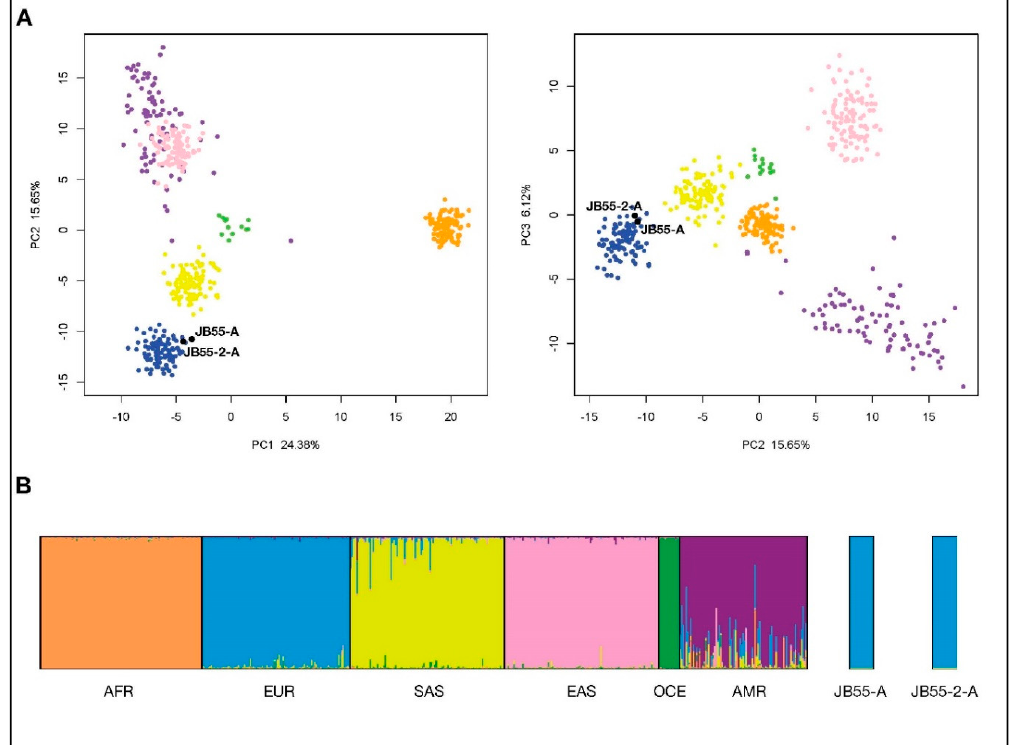
Figure 3. Bio-geographical ancestry inference for the two JB55 extracts using the Precision ID Ancestry single nucleotide polymorphism (SNP) panel and custom reference data. ( a ): Graphical representation of the principal components analysis (PCA) showing principal components (PC) 1 and 2 (left), and 2 and 3 (right). ( b ): Plot represents proportions of ancestry for K = 6 obtained with STRUCTURE. Individuals are colored in the PCA according to the six different clusters corresponding with six major populations in the STRUCTURE plot—AFR: Africa, EUR: Europe, SAS: South Asia, EAS: East Asia, OCE: Oceania and AMR: America.